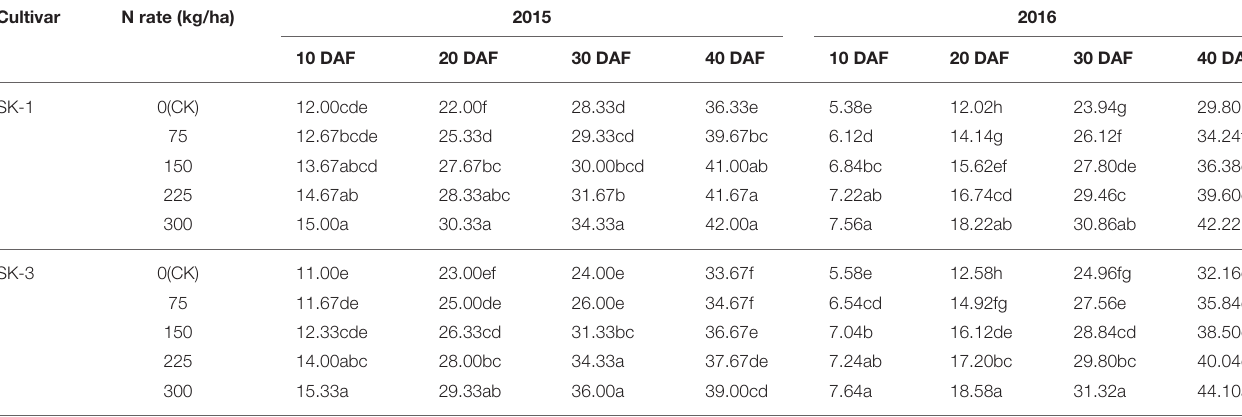
TABLE 2 | The effect of the nitrogen level on the boll volume (cm 3 ) of the two Bt cotton cultivars in 2015 and 2016. Cultivar